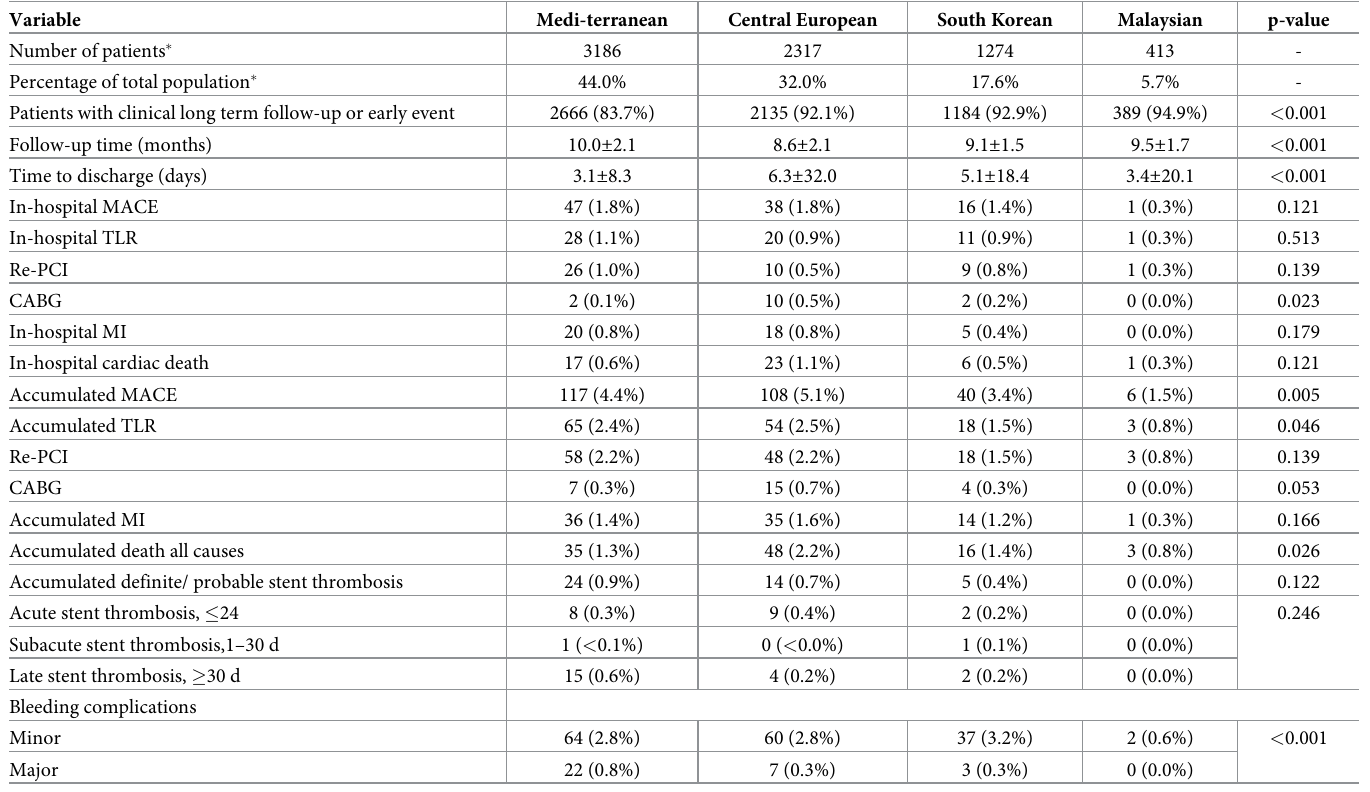
Table 3. Clinical